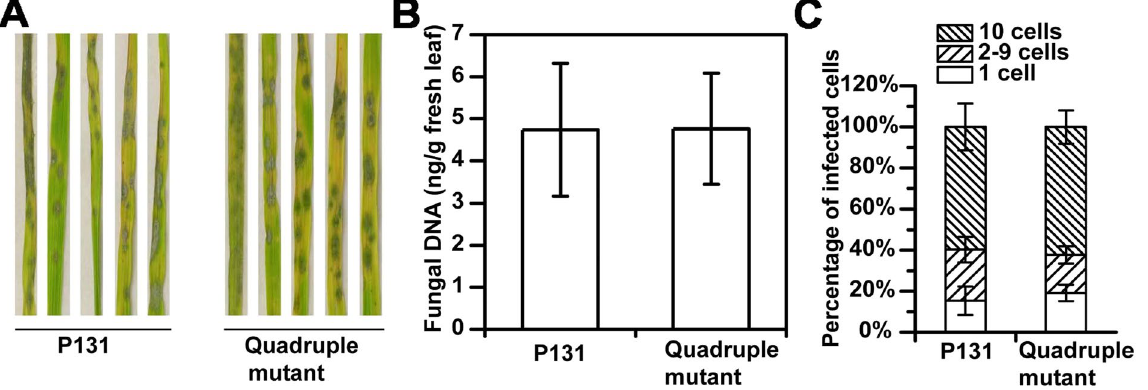
Figure 6. The MoNLP family is dispensable for virulence of M. oryzae on rice plants. ( A ) Disease symptoms caused by wild type and mutant fungal strains are similar on rice leaves. Ten-day-old susceptible rice seedlings (cv. LTH) were sprayed with conidial suspensions (1 × 10 5 conidia ml − 1 ) and incubated at room temperature with high relative humidity. Leaves were photographed at 5 days post inoculation. ( B ) The fungal growth of quadruple mutant is similar to that of wild type during infection. Samples were collected and weighted at 120 hpi, and DNA was extracted for qPCR assay of the fungal Actin . The fungal growth was quantitatively determined by the amount of fungal DNA in fresh leaves. ( C ) Percentages of types of infection sites classified by number of cells occupied by infectious hyphae on leaf sheath. The hollow space of sheaths (6.5 leaf stage) was injected with conidial suspension (5 × 10 3 conidia ml − 1 ). The infected tissues were stained with lactophenol cotton blue at 72 hpi. At least 40 infection sites were examined for each of the four plants used. Data shown in ( B ) are means ± sd (n = 4), and in ( C ) are means ± se (n = 4). Experiments were repeated at least twice with similar